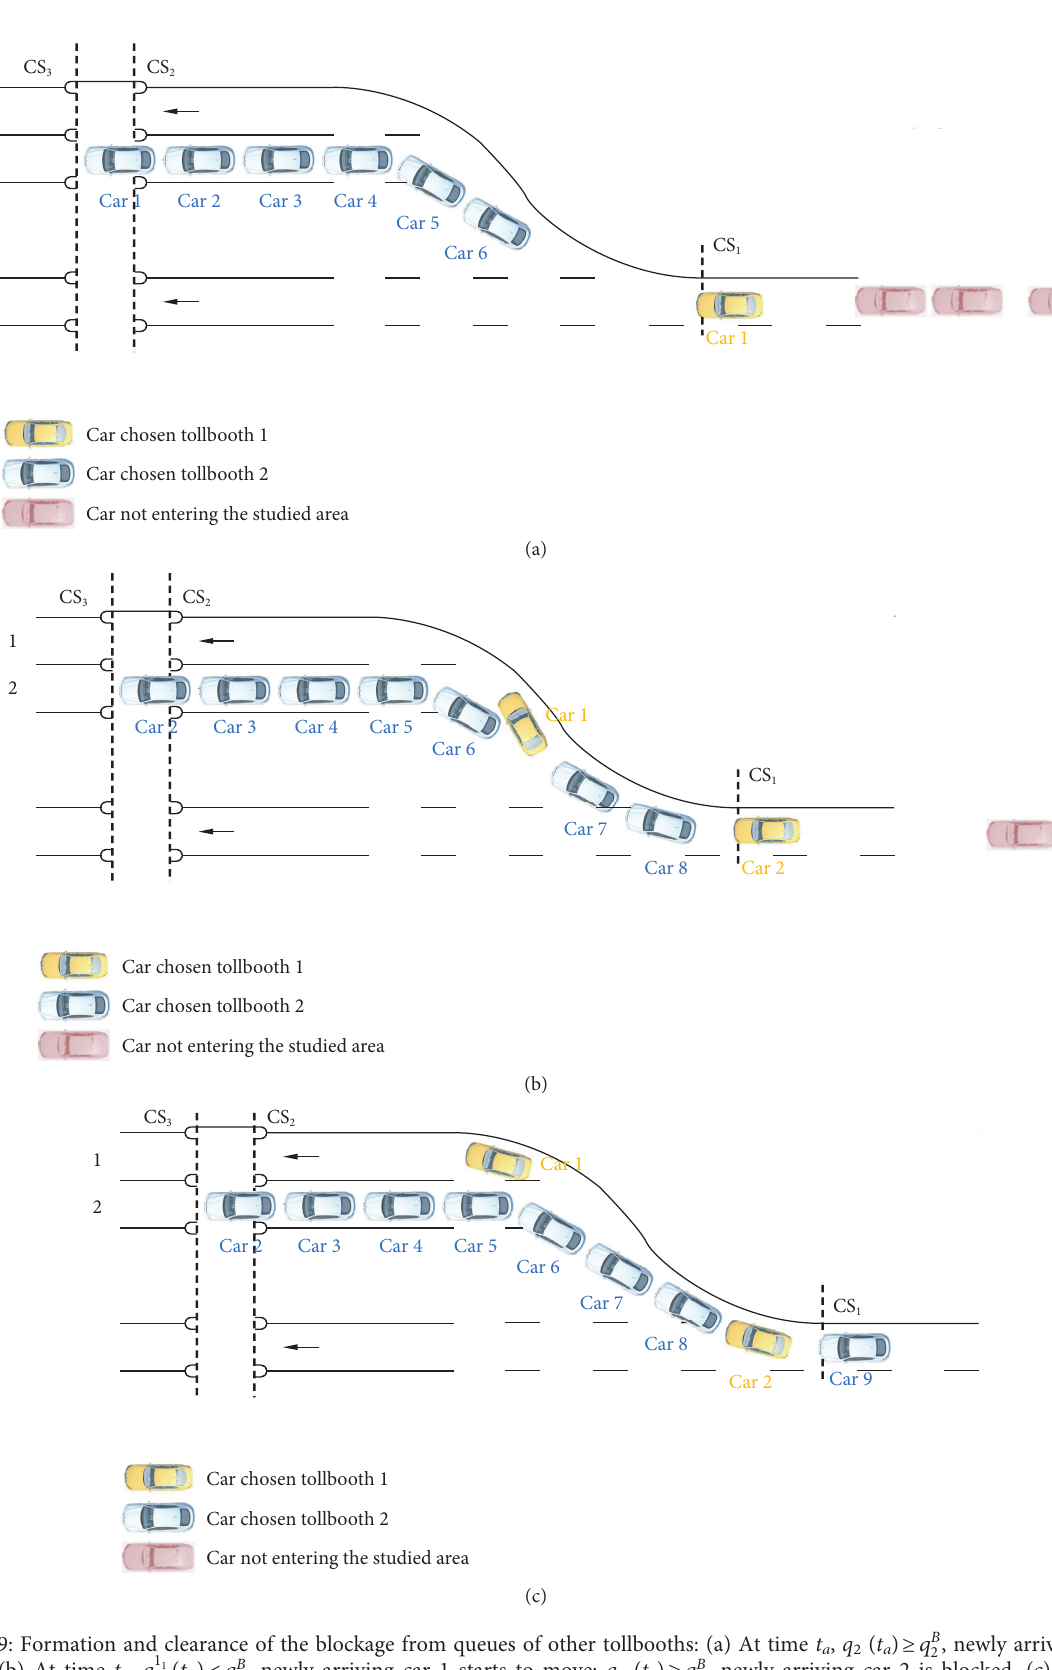
( t ) < q B , newly arriving car 1 starts to move; q 2 ( t a ) ≥ q B b 2 2